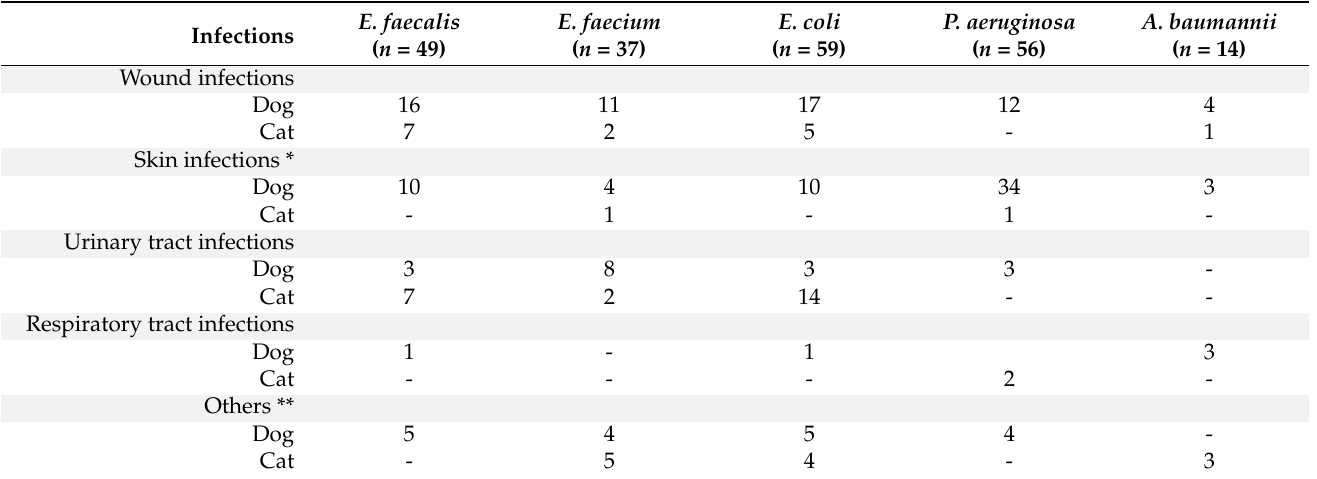
Table 6. Origin of the